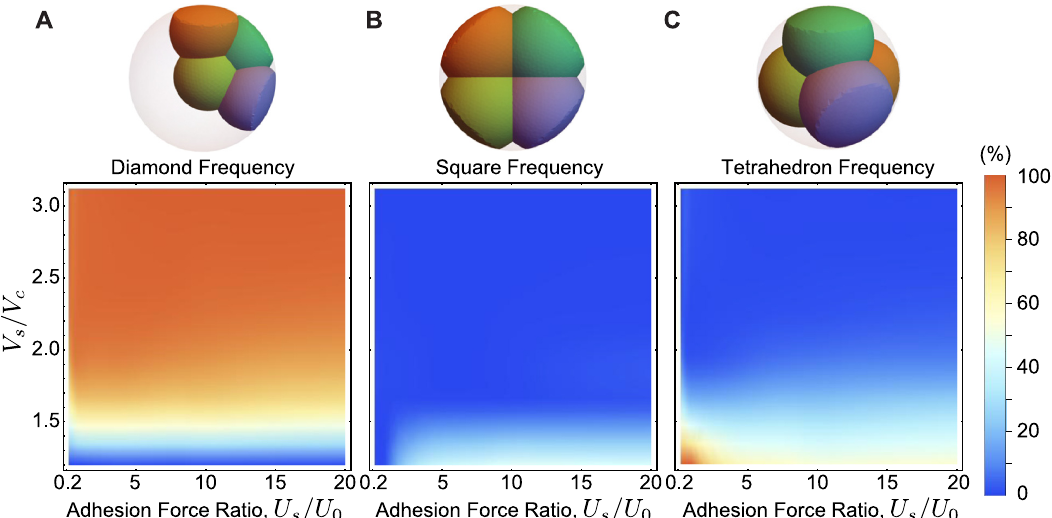
Fig 5. Cell packing arrangements in a sticky confining shell. A-C , Frequency of packing arrangements (A, diamond; B, square; C, tetrahedron) for varying values of the shell volume to cells volume ratio, V s / V c , and cell-shell to cell-cell adhesion strength, U 0 (n = 5000 simulation runs for each parameter